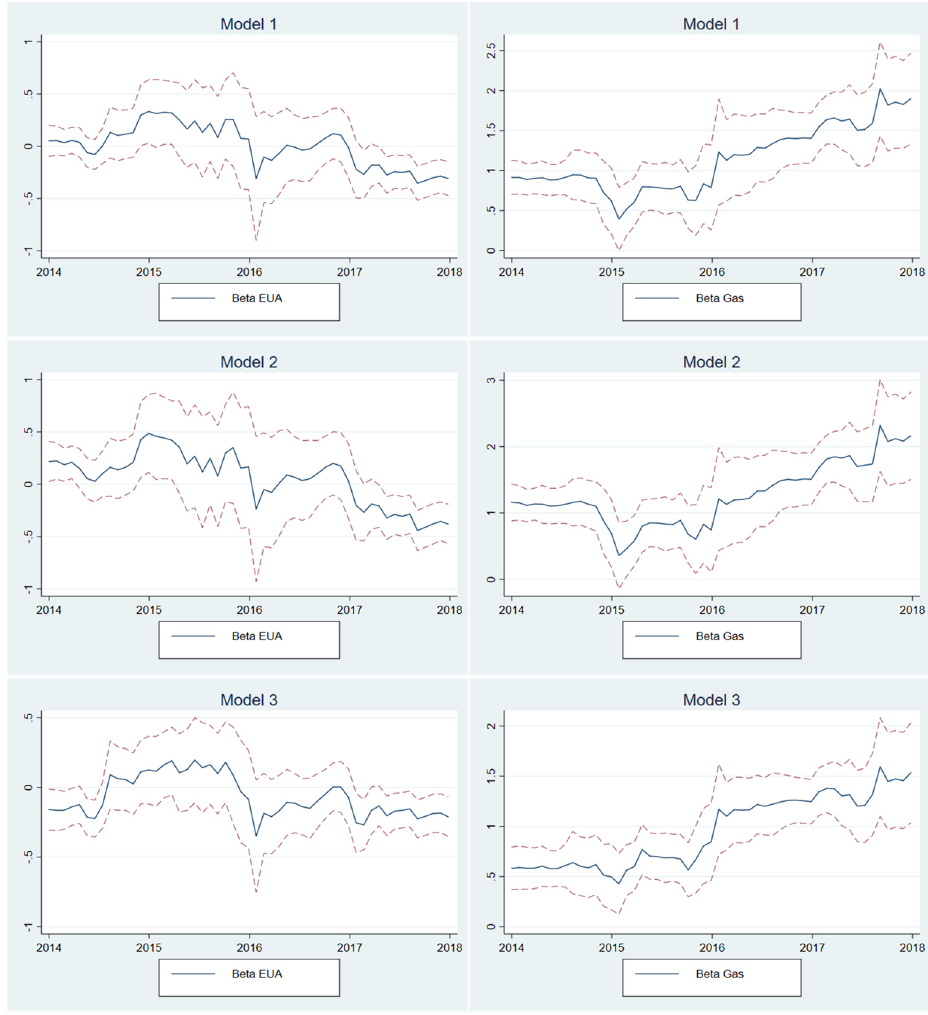
Figure 1. Rolling analysis for Models 1, 2 and 3. The graphs show the beta coefficients (and their relative confidence intervals) for allowances (left-hand side) and natural gas (right-hand side) resulting from the rolling